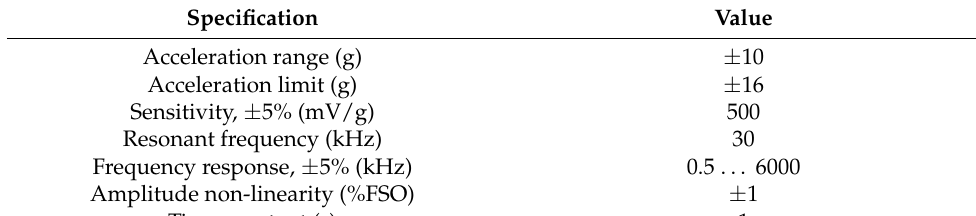
Table 4. Technical specifications of the Kistler accelerometer [7].